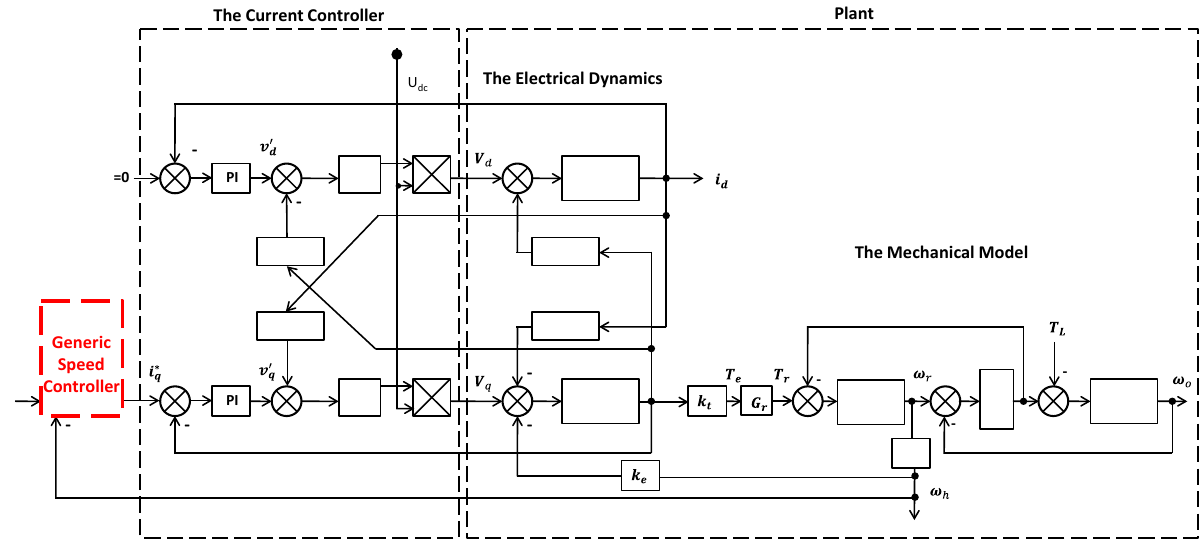
Figure 4. Schematic of the Pseudo Direct Drive under a speed